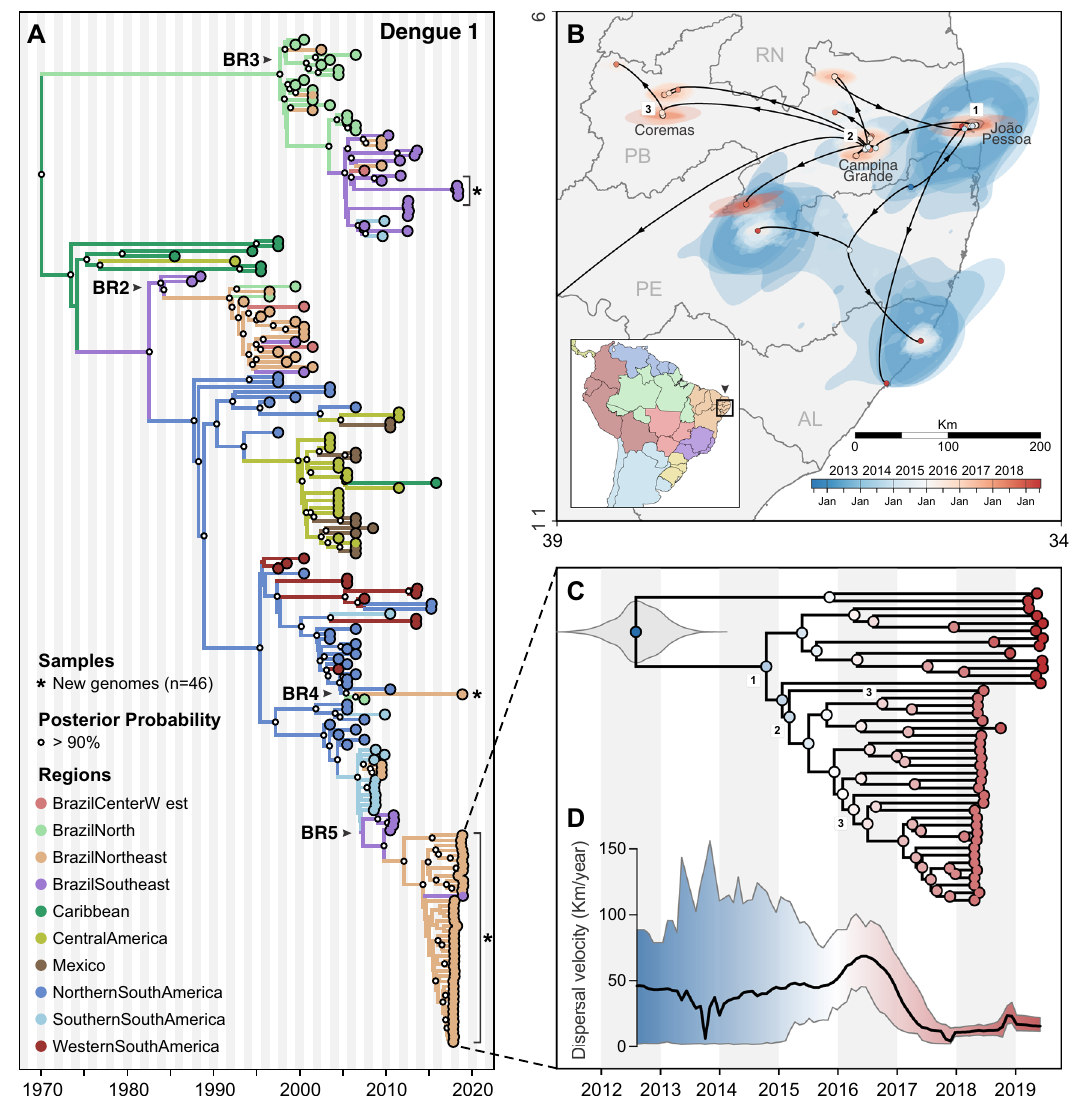
Fig. 5 Regional emergence and cryptic transmission of DENV-1 causing recent outbreaks in Northeast Brazil. A Time-resolved phylogeny of DENV-1 circulating in the Americas since 1986 ( n = 200). Branch colors represent reconstructed ancestral locations using discrete phylogeography. BR2 – BR5 represent lineages of DENV-1, numbered in sequential order based on their dates of introduction in Brazil, as previously described 49 . DENV-1 genomes sequenced in this study ( n = 46) are highlighted with asterisks (*). B Continuous phylogeography showing the local spread of DENV-1 in the Northeast Brazil states of Paraíba (PB), Alagoas (AL), and likely Pernambuco (PE). Areas numbered as 1 (João Pessoa), 2 (Campina Grande), and 3 (Coremas) correspond to the main location where DENV-1 circulated in 2018 – 2019 (see Fig. 2A). Shaded areas represent uncertainties, expressed as the 80% highest posterior density (HPD) of the possible locations of origin of viral ancestors. C The main DENV-1 outbreak clade plotted as movement vectors in ( B ). The violin plot shows the posterior density interval for the TMRCA. Numbers refer to areas shown in ( B ). D Weighted lineage dispersal velocity through time, reaching its peak around June 2016, with mean velocity of 69.1 km/year (con fi dence interval, 45.07 – 90.91 km/year). To better depict the dynamics of spread in Northeast Brazil, the single vector leading to São Paulo was not considered in the calculations of dispersal